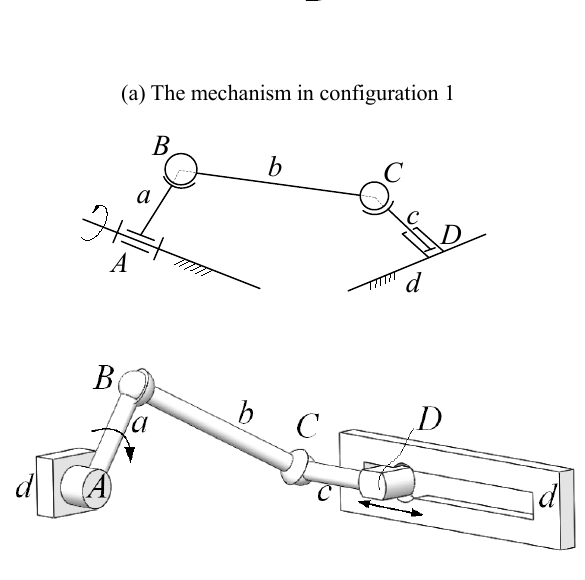
RSSR mechanism. The axis of joint D between links c and d is perpendicular to the axis of joint A between links a and d .